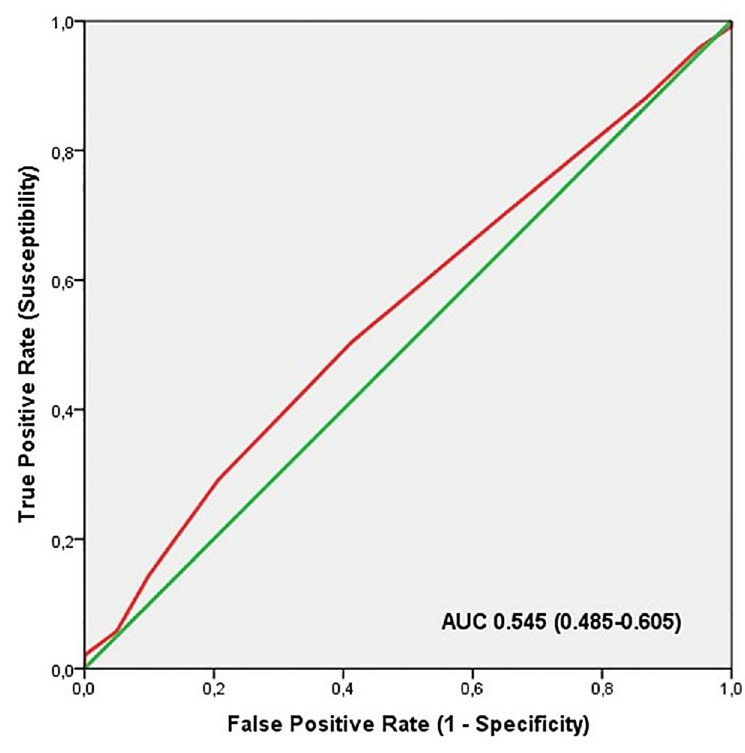
Fig 6. ROC curve summarising the ability of TGS in cardiorespiratory fitness genes to distinguish potential professional athletes from non-athletes.